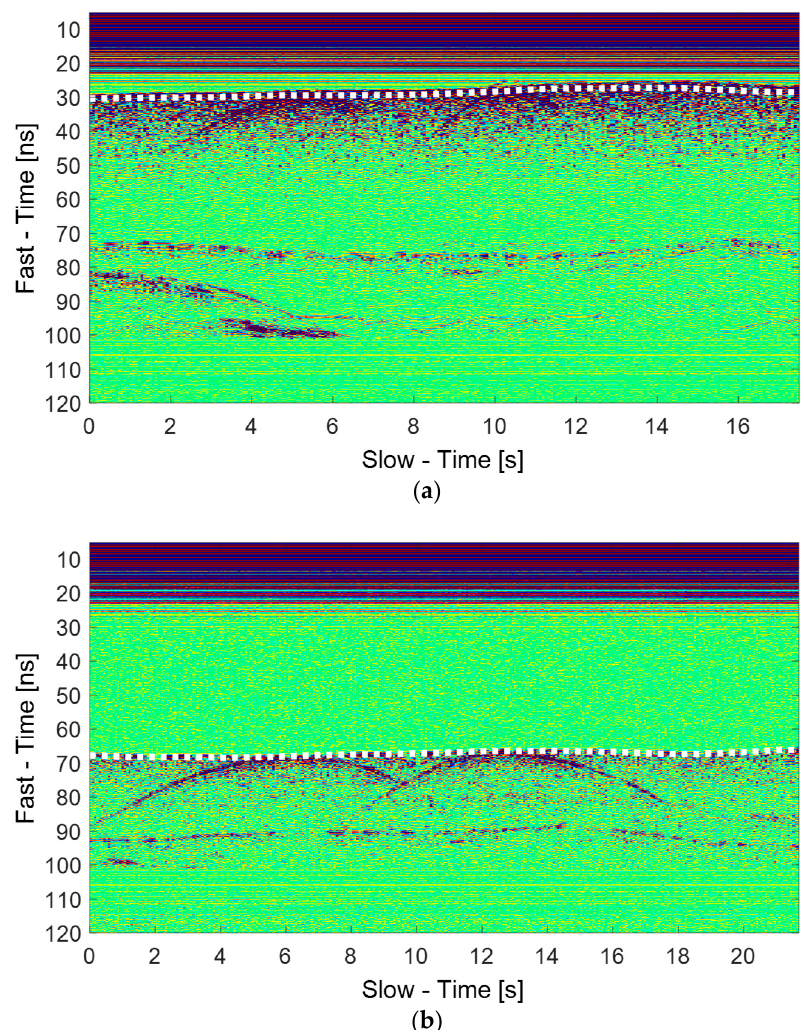
Figure 10. Raw radargrams: ( a ) Track 1; ( b ) Track 2. The white dotted line represents the variable UAV flight altitude h estimated by the Carrier-Phase Differential GPS (CDGPS) and transformed into the equivalent travel time by: t h = 2 h / c 0 .